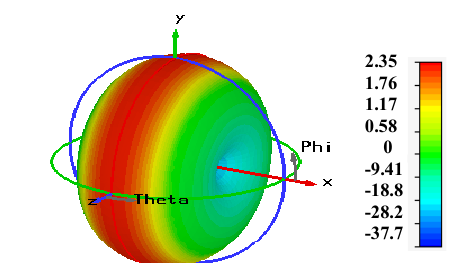
Figure 9. The 3-D radiation pattern of the rhombic dipole IR-nanoantenna on a dielectric substrate with h=150 nm, w=5 µm, t=50 nm, gap=100 nm, L =2.2 µm at 28.3 THz. s The rhombic shape introduces a higher received electric field across the gap than the round and rectangular antennas. The electric field intensity is decreased with increasing the rotation angle of incident plane wave electric field. For oblique incident p lane wave propagated at angle ϕ =0 and